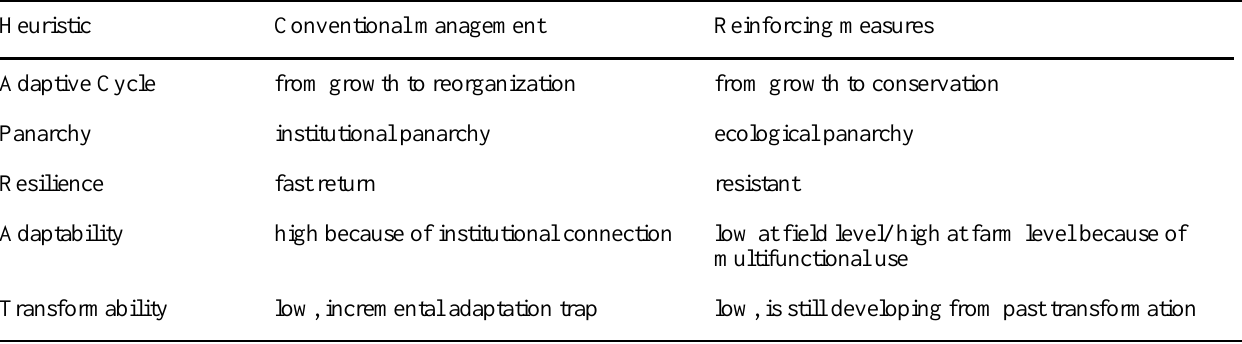
Table 1 . Summarized findings of our analysis of conventional managed systems and the reinforcing